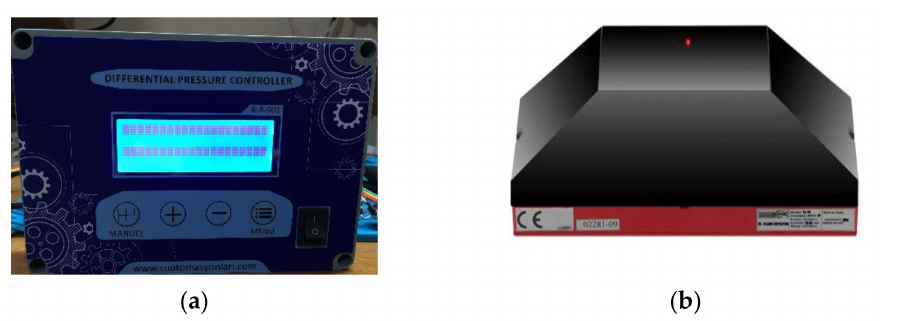
Figure 14. ( a ) Control panel, ( b ) Flame